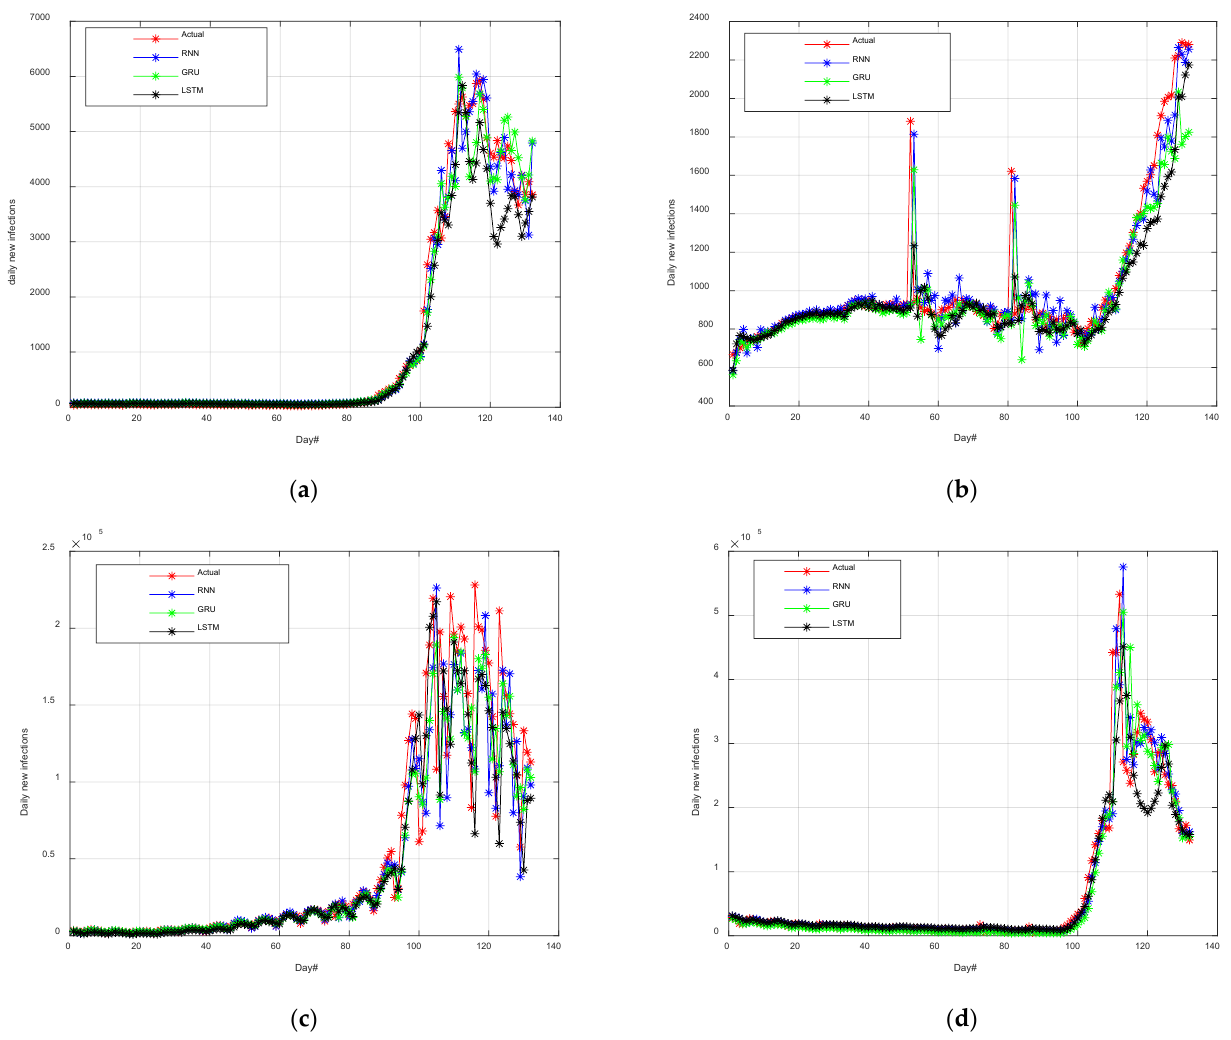
Figure 3. Curves of the new daily infections obtained by RNN, GRU, and LSTM for ( a ) Saudi Arabia, ( b ) Egypt, ( c ) Italy, and ( d ) India. Day 1 is 9 September 2021. Table 4. Performance metrics of the RNN, GRU, and LSTM DL algorithms during the testing pe- riod (Saudi Arabia and Egypt).